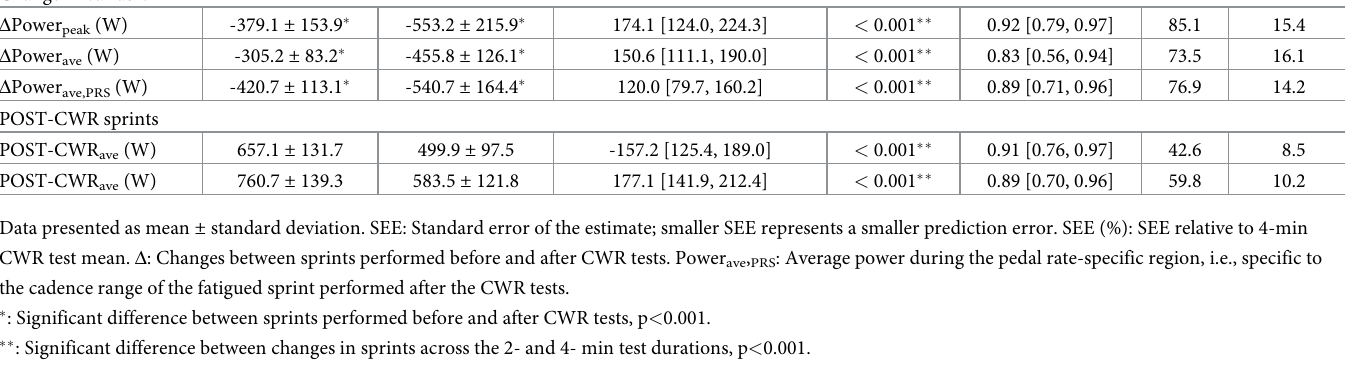
Fig 3. _ VO -time profiles for 2- and 4-min CWR tests in a representative participant performed on different days. 2 _ VO kinetics are inferred by the mean response times (Corrected MRT 2min = 25.3 s vs. MRT 4min = 23.6 s) and the _ VO 2 steady state, as fitted by a mono-exponential function which were similar for both tests. The bottom black and grey lines represent the residuals. The darker and lighter grey shaded regions show the 2- and 4-min CWR test durations, respectively.